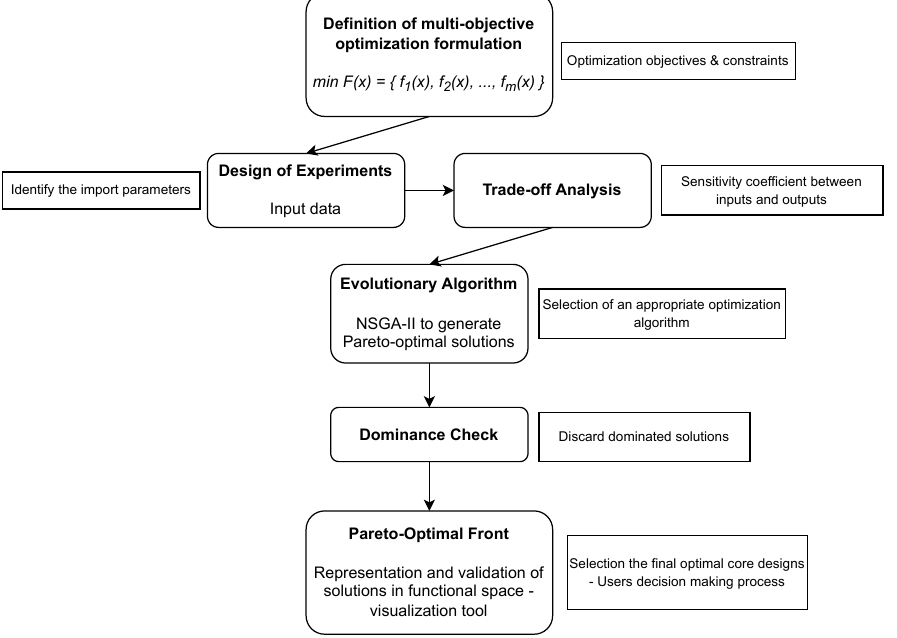
Figure 3. Multi-criteria optimization